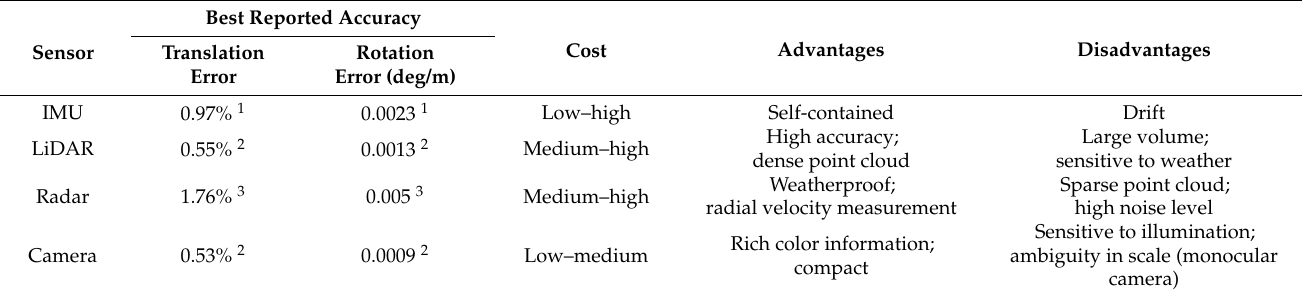
Table 6. Comparison of onboard sensors for indoor